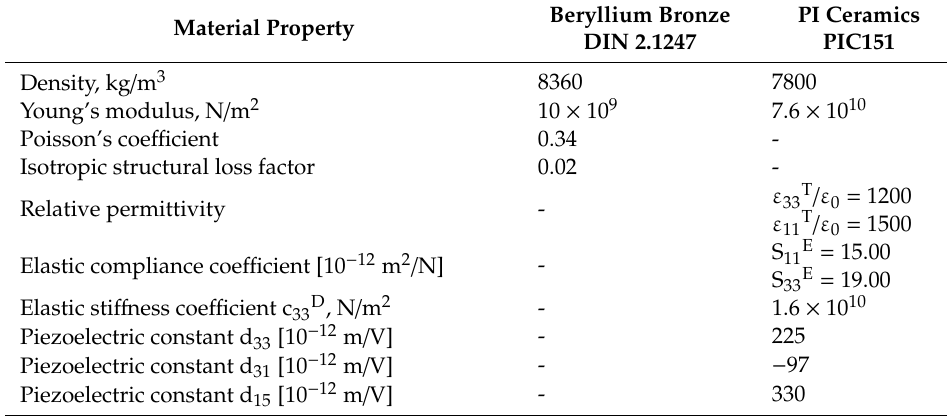
Table 2. Properties of the materials.